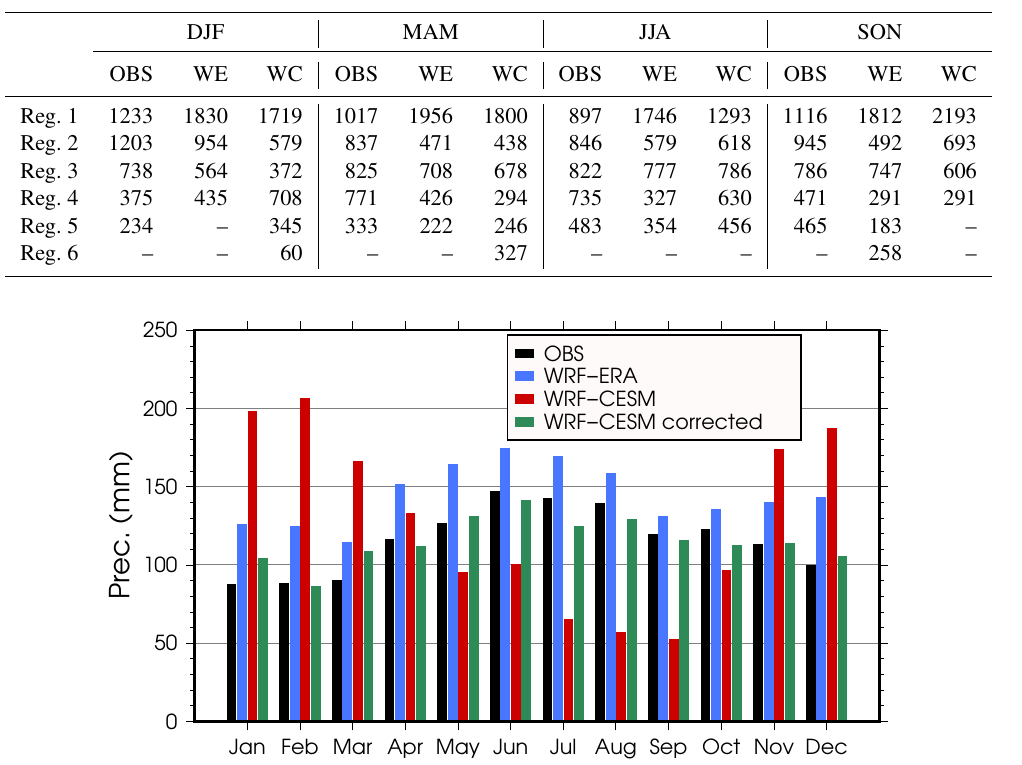
Table 2. Number of grid points that belong to each of the regions shown in Fig. 2. Only grid points within the Swiss domain, i.e. those not missing values in OBS, are counted. Note that in some cases the number of regions is lower than 6; therefore, we indicate it with en dash.